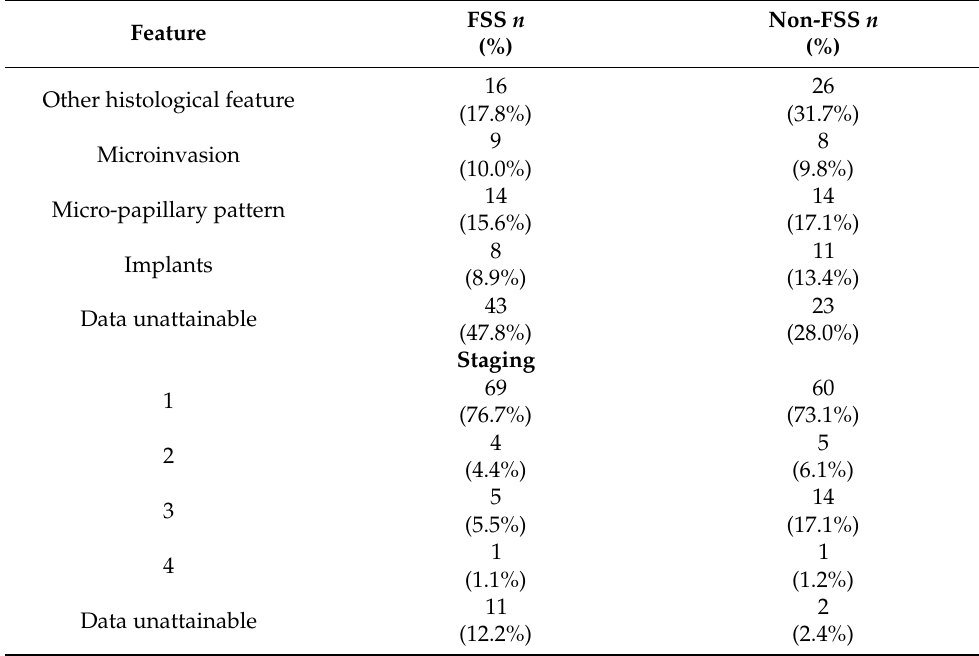
Table 2. Histopathological features from primary